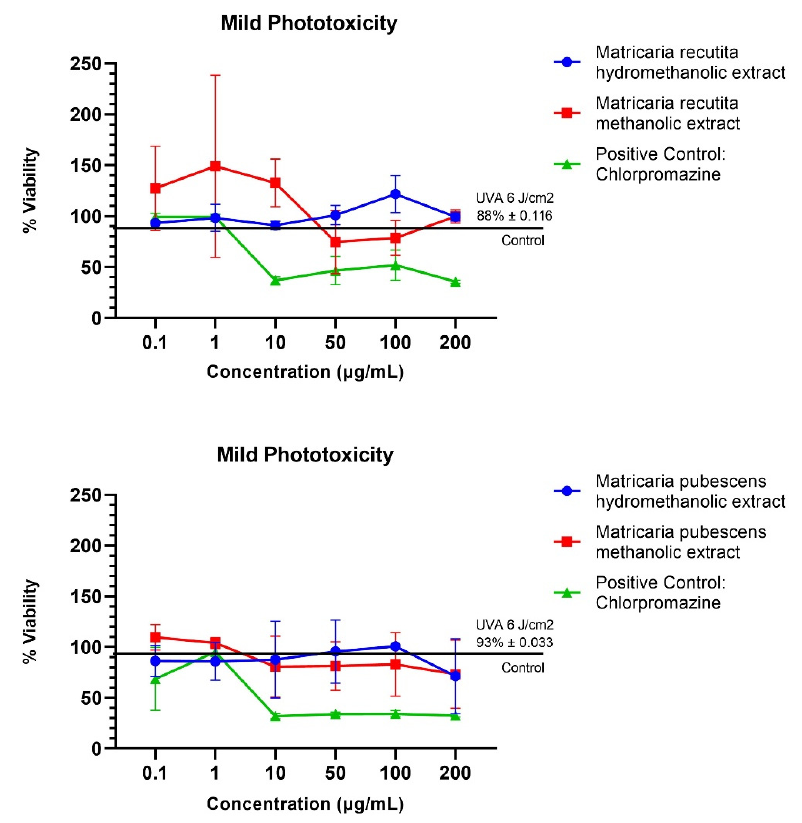
Figure 5. % Viability of M. pubescens and M. recutita methanolic and hydromethanolic (75%) extracts in UV-A-irradiated BALbC 3T3 fibroblasts. Viability of 100% corresponds to non-UV-exposed cells.